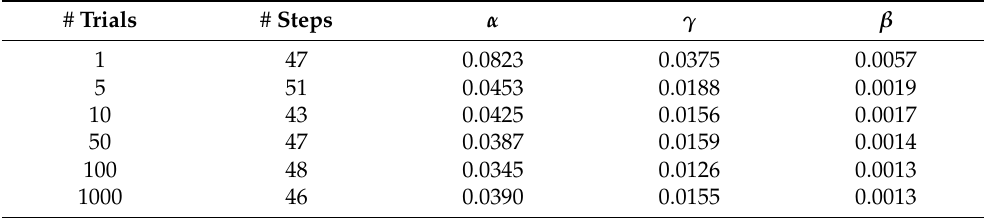
Table 4. Average values of the parameters estimated using the Nelder–Mead algorithm as a function of the number of trials. The number of required iteration steps to achieve these estimated parameters is also reported. The values of actual parameters are α = 0.0429, γ = 0.02011, β = 0.00137. # Trials #